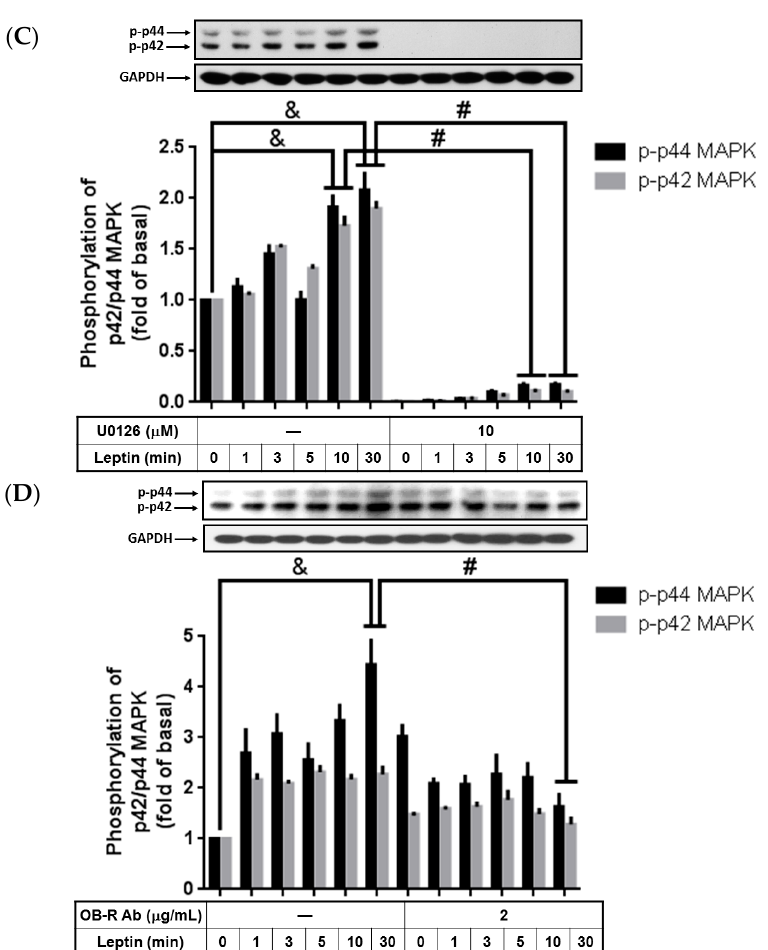
Figure 2. Pretreatment with PD98059 and U0126 on leptin-stimulated A549 cells. Serum-starved A549 cells were pretreated with different concentrations of U0126, PD98059, or the OB-R antibody for 1 h and then stimulated by 1 µg/mL of leptin for the indicated time intervals. At the end of incubation, the cells were harvested and cell lysates were extracted. ( A , B ) Expression of cPLA 2 - α and ( C , D ) phosphorylation of p42/p44 MAPK were detected using Western blot with anti-cPLA 2 or anti-phospho p42/p44 MAPK antibodies. Cell membranes were stripped and reprobed with the anti-GAPDH antibody as internal controls. The data are expressed as mean ± SEM of five independent experiments ( n = 5). & p < 0.05 as compared with the cells exposed to the vehicle alone; # p < 0.01 or * p < 0.05 as compared with the cells exposed to leptin.